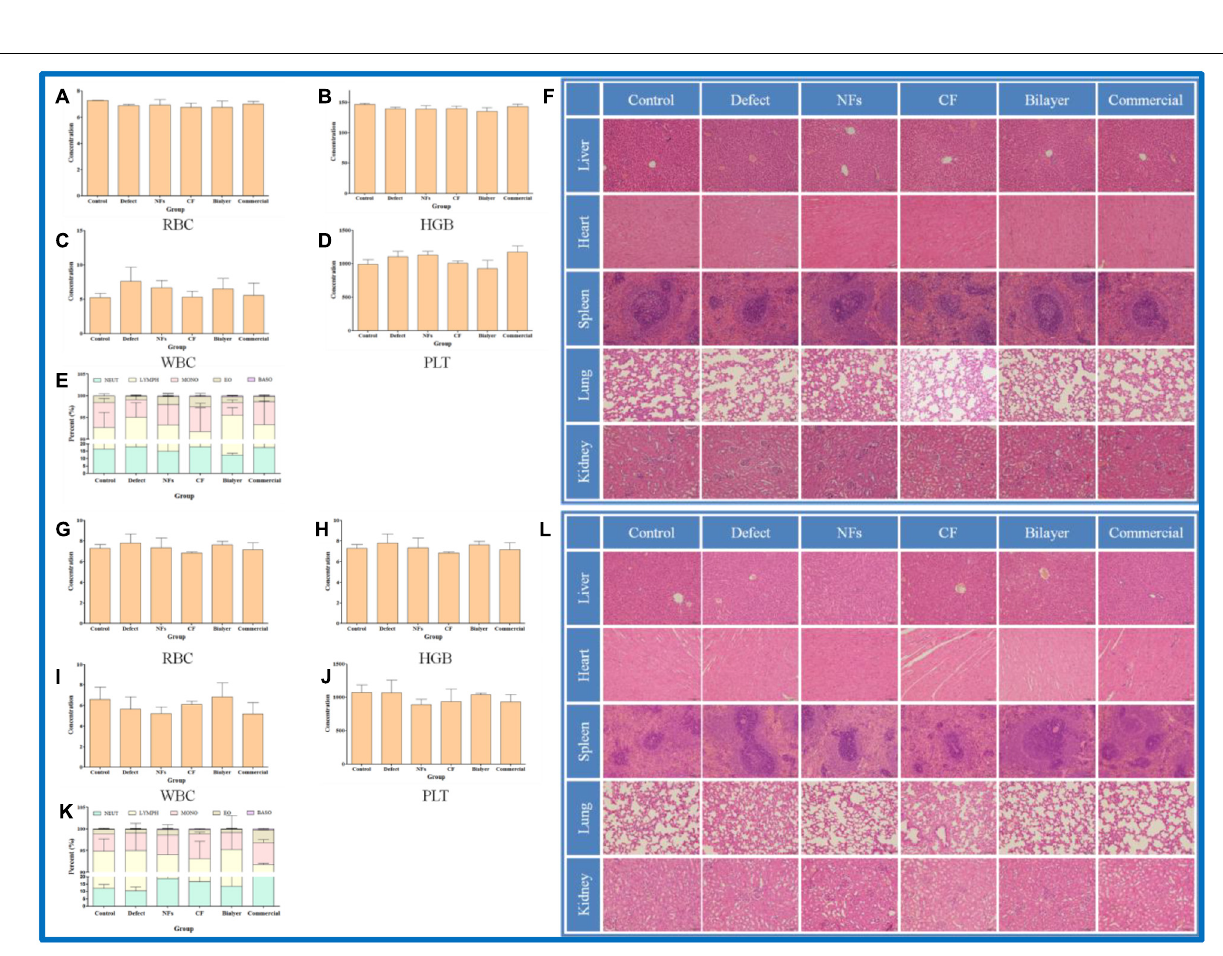
FIGURE 8 | (A–L) Biocompatibility evaluation of membranes in vivo at 4 weeks (A–F) and 8 weeks (G–L) . Percentage of red blood cells (A,G) , hemoglobin (B,H) , leukocytes (C,I) , and platelets (D,J) and 5 types of leukocyte (E,K) in rats. (F,L) Histopathologic analysis by H&E staining of liver, heart, spleen, lung, and kidney tissues. Scale bar, 100 µ